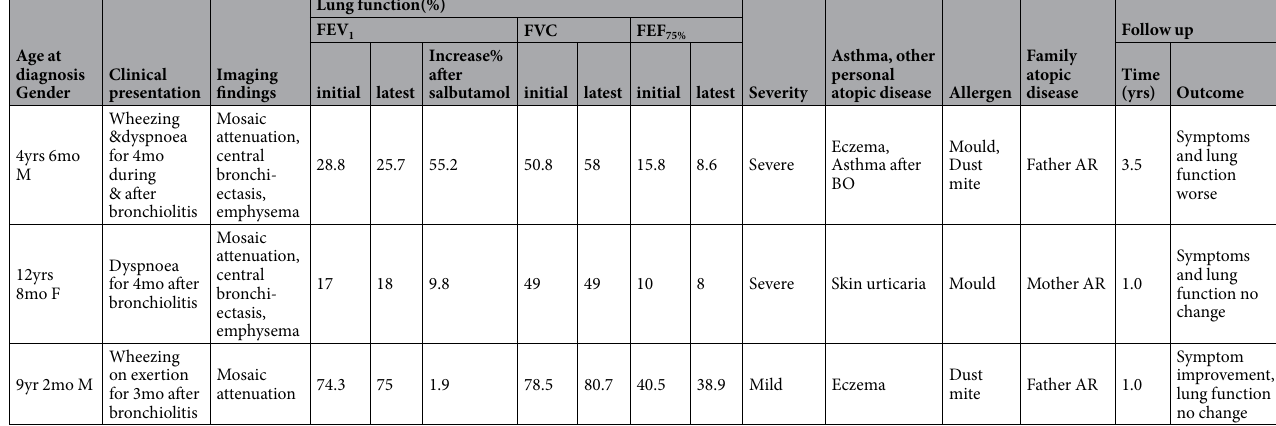
Table 1. Demographic and Clinical Features of 17 Patients with BO. Abbreviations: F, female; M, male; mo, month; BO, Bronchiolitis obliterans; AR, allergic rhinitis; FEV 1 , forced expiratory volume in 1 second; FVC, forced vital capacity; FEF, forced expiratory flow; yrs,